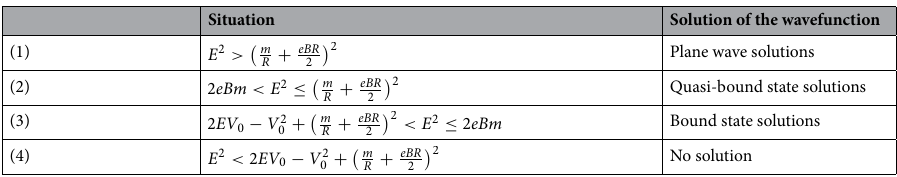
versus B relations for −